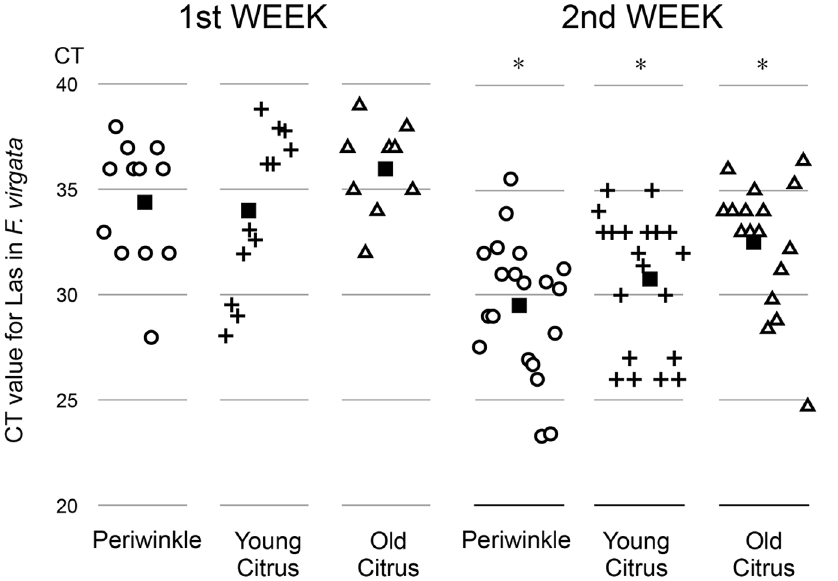
Figure 1. Ct values of single mealybug (Ferrisiavirgata) after feeding for one and two weeks on ‘ Candidatus Liberibacter asiaticus’ (Las)-infected periwinkle, young citrus and old citrus leaf discs. The black squares indicate the Ct means. The presence of Las was assessed using 16S rDNA-based primers and probe [27]. Asterisks indicate that the mean Ct value from the second week is significantly different from the first week’s mean Ct value. (Periwinkle (p , 0.002), young citrus (p , 0.013), and old citrus (p , 0.0069) using Student’s t-test.). doi:10.1371/journal.pone.0085503.g001 under a stereomicroscope and tissue organs were collected for qPCR analysis (Figure S1B, C). Salivary glands, alimentary canals and the rest of the body were dissected from positive F. virgata adults. The average Ct value was 27.5 (3.98 6 10 6 cells) from the gut, 37.5 (4.08 6 10 3 cells) from the salivary glands and 32.1 (1.68 6 10 5 cells) from the rest of the body. Salivary glands were Las positive in 30% of the cases with a Ct value ranging from 36.5 (8.12 6 10 3 cells) to 37.8 (3.32 6 10 3 cells) (Table 2a). The Las titer